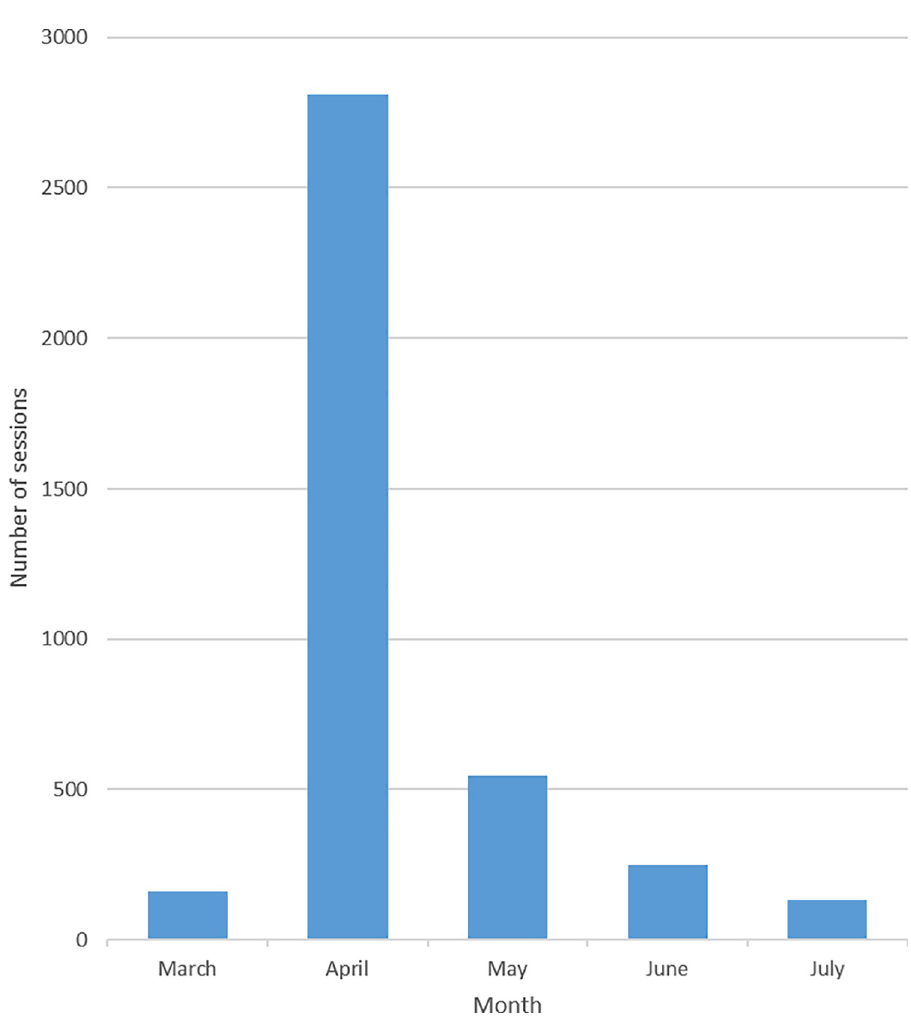
Fig 2. Number of COVID-19 app sessions per month.